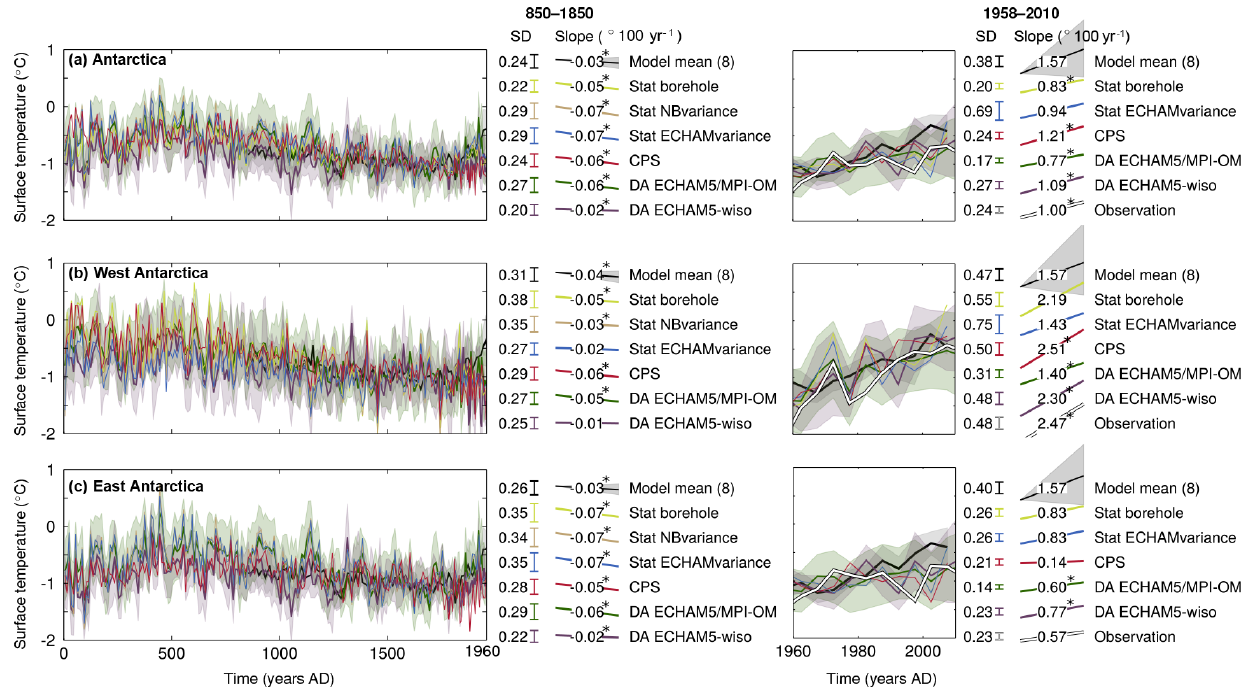
Figure 8. Changes in 10- (left panels) and 5-year averaged (right panels) simulated and reconstructed surface temperature over the 0– 2000CE period over (a) Antarctica, (b) West Antarctica and (c) East Antarctica. The model mean and ± one standard deviation of the individual simulations are shown in black and shaded gray, respectively; the statistical reconstructions of Stenni et al. (2017) are shown in yellow, beige and blue. Stat NBvariance uses a temperature scaling based on the temperature observations of Nicolas and Bromwich (2014) over the 1960–2010CE period (see Sect. 2.5 for more information), Stat ECHAMvariance uses a temperature scaling based on the simulated δ 18 O–temperature link in a ECHAM5-wiso simulation over the 1979–2013CE period (Goursaud et al., 2018), and Stat borehole also uses a scaling based on the simulated δ 18 O–temperature link in ECHAM5-wiso, but the WAIS region is adjusted to match the temperature trend between 1000 and 1600CE based on borehole temperature measurements from Orsi et al. (2012). The data assimilation reconstructions based on the ECHAM5/MPI-OM and ECHAM5-wiso model ensembles are shown in green and violet, respectively. The uncertainty of the data assimilation-based reconstructions is shown using colored shading ( ± 1 standard deviation of the model particles scaled by their weight around the mean). The reconstructions based on instrumental records (Nicolas and Bromwich, 2014) are shown using a white line (in the right panels only). The reference period is 1500–1800CE for the left panels, and 1960–1990CE for the right panels. The standard deviation and the slopes of the series (in ◦ C/100 years) are shown for the 850–1850CE (or overlap period) and 1958–2010CE periods; slopes proportional to the numbers are also displayed. When the trends are significantly different from zero according to F -tests ( p < 0 . 05), the slope values are followed by an asterisk ( ∗